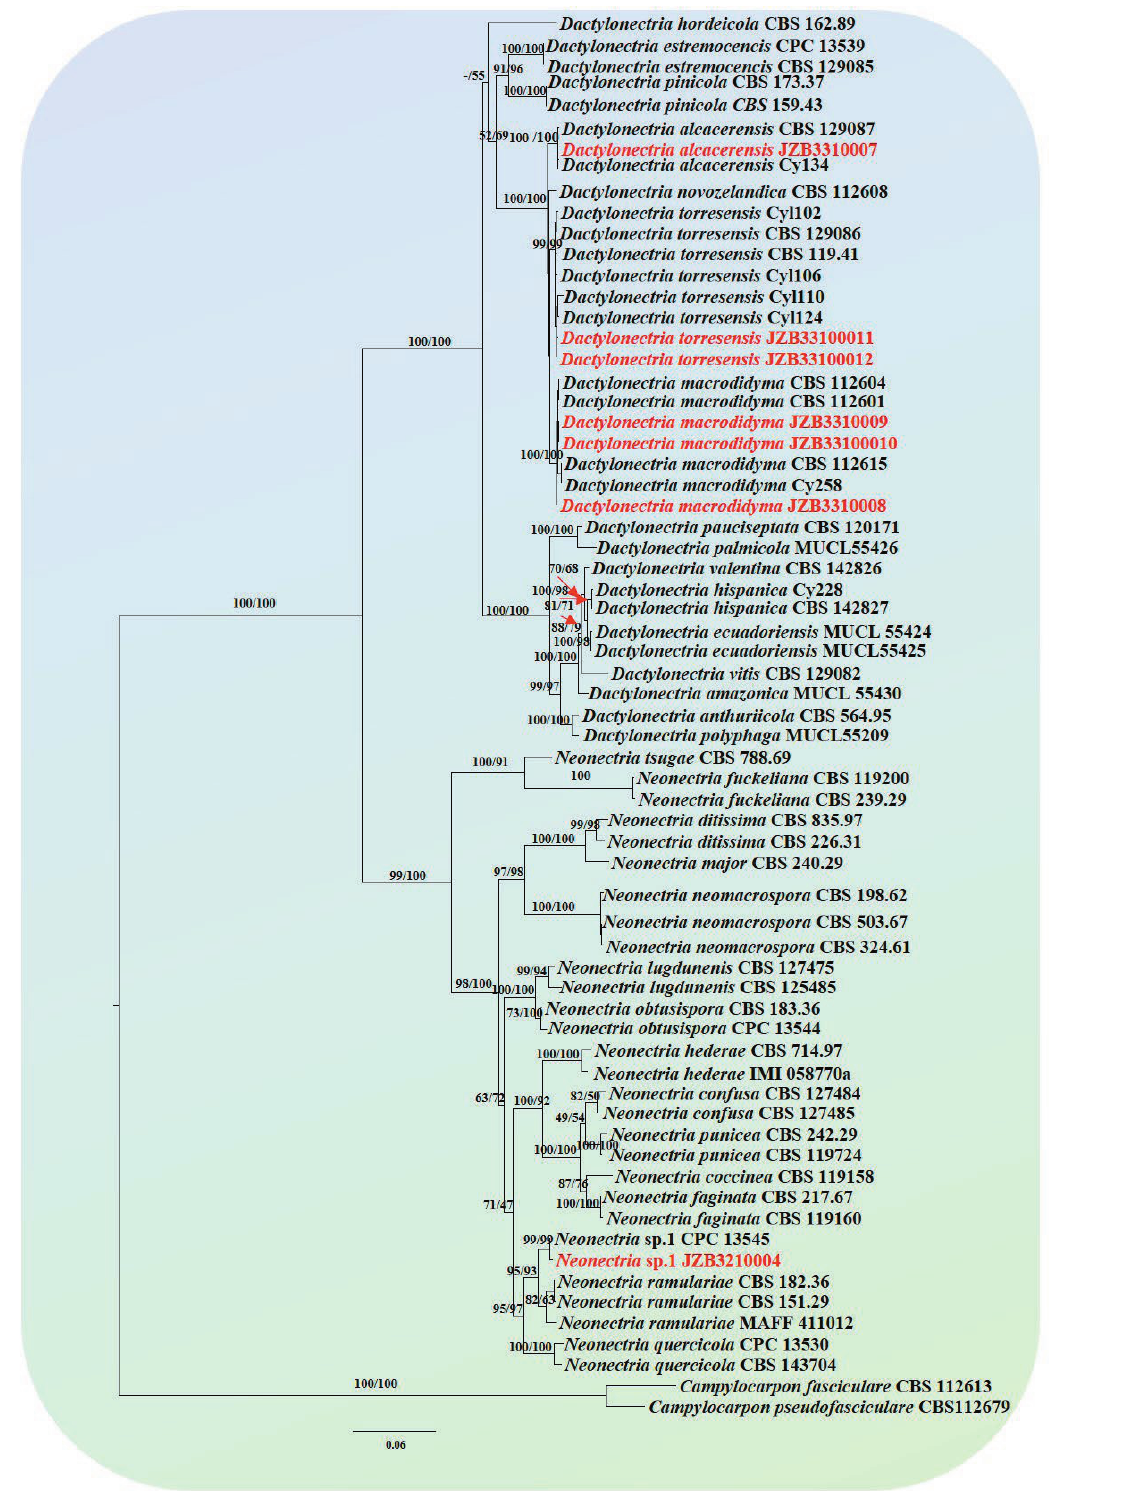
Figure 3. Maximum likelihood tree obtained from the phylogenetic analysis based on combined ITS, tub2 , his3 , and tef1 sequence align- ments. The scale bar represents 0.05 changes. The ex-type strains are in bold font. The outgroups of the tree are Campylocarpon fasciculare (CBS 112613) and C. pseudofasciculare (CBS